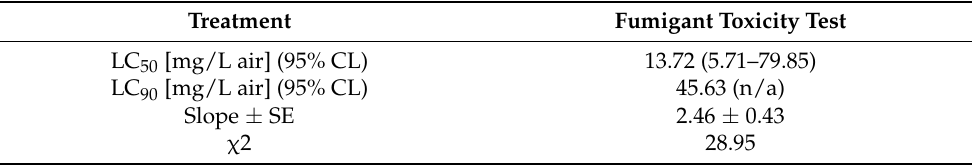
Table 5. Lethal concentration (LC 50 and LC 90 ) of Piper nigrum L. essential oil against Stomoxys calcitrans by fumigant toxicity testing 24 h after